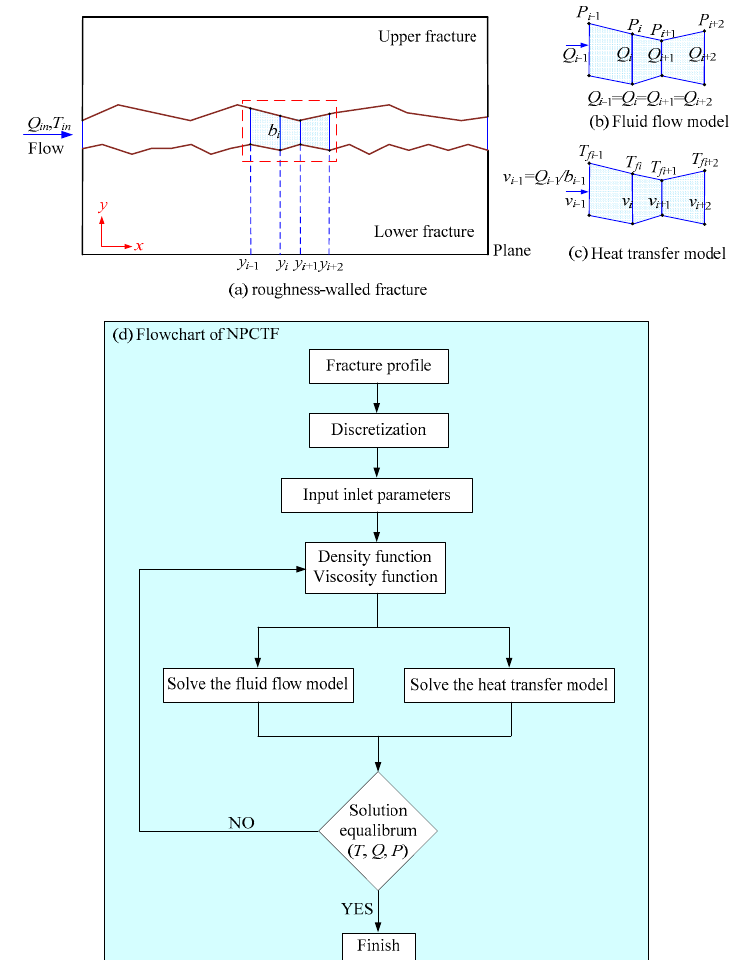
Figure 3. Computational flow chart of the proposed novel procedure for coupled simulation of thermal and fluid flow models (NPCTF). (a) Roughness ‐ walled fracture; (b)Fluid flow model; (c) Heat transport model; (d)Flowchart of NPCT